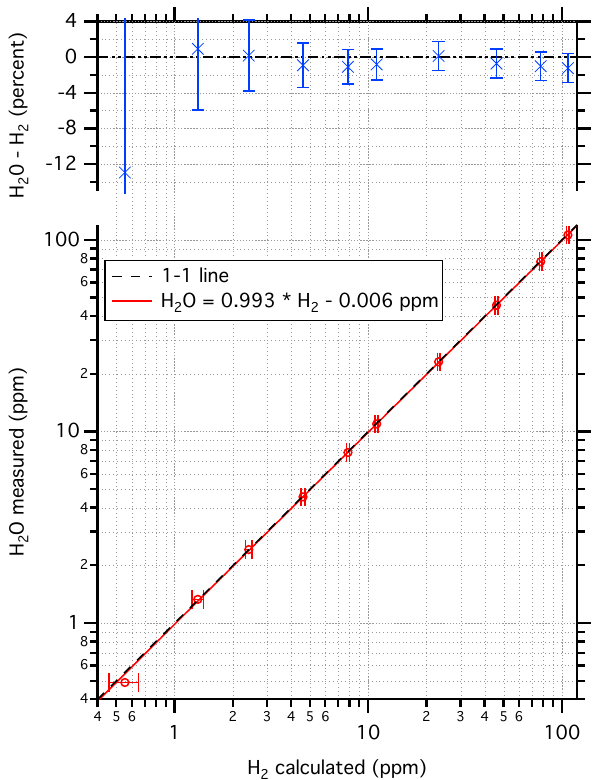
Fig. 3. Observed water vapor mixing ratios produced from a dy- namic dilution of an H 2 /zero air mixture. Error bars represent the 2 σ uncertainty in expected H 2 O due to accuracy of the H 2 bottle ( ± 0.75%), 3 flow controllers (1% each) and H 2 O in zero air used for dilution (0 . 1 ± 0 . 1ppm). Top panel: Vertical range is selected to clearly show the uncertainty range for most of the points. The lowest concentration point (0.55ppm) has an uncertaint of ± 20% which exceeds the range shown. Water vapor was measured with an MBW 373LX